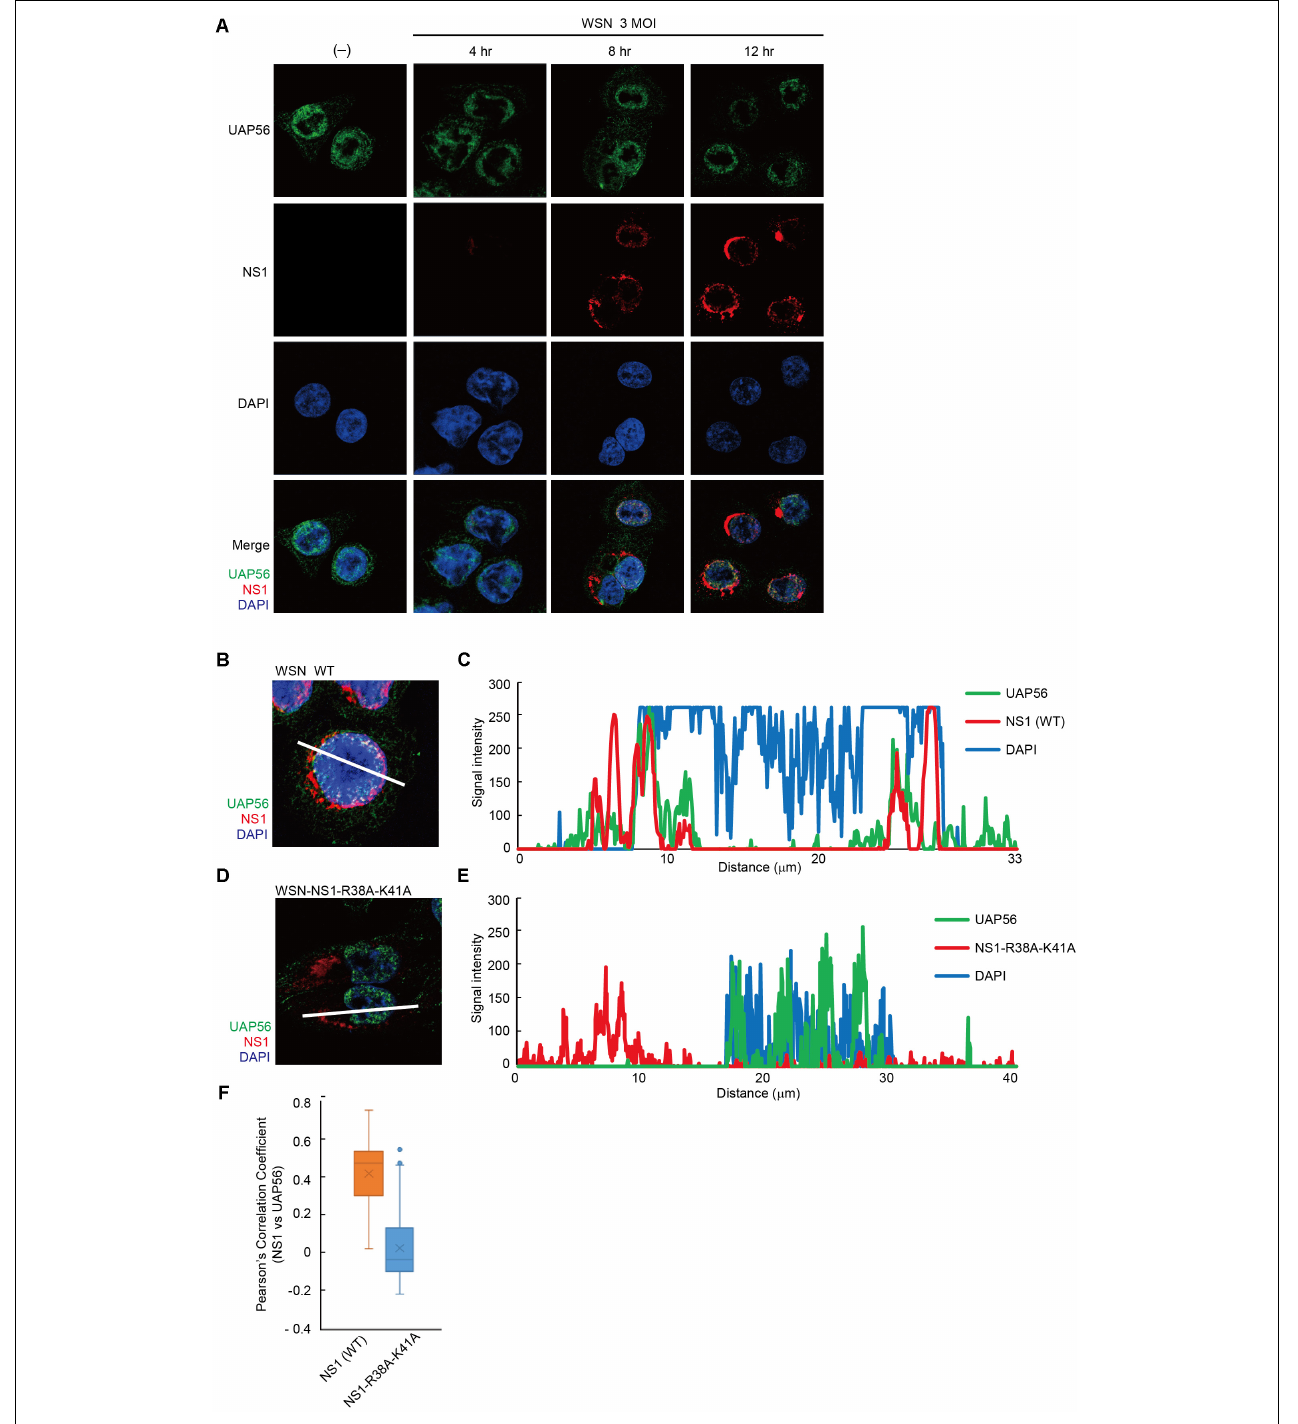
FIGURE 4 | Localization of UAP56 and NS1 in WSN-infected A549 cells. (A) A549 cells were infected with WSN virus at an MOI of three. At 4, 8, or 12 h post-infection, the cells were fixed with 4% paraformaldehyde in PBS. The cells were then analyzed with specific antibodies against UAP56 and NS1. (B–E) Representative immunofluorescence images of A549 cells at 12 h post-infection with wild-type (WT) WSN virus (B) or WSN-NS1-R38A-K41A mutant virus (D) at an MOI of 3. The cells were analyzed with anti-UAP56 (green) antibody, anti-NS1 (red) antibody, and DAPI (blue). (C,E) Signal intensities across the line shown in B , D , respectively, were plotted and analyzed by using LSM510 META and ZEN2009 software. (F) A549 cells infected with WSN WT virus ( n = 102 cells) or WSN-NS1-R38A-K41A mutant virus ( n = 100 cells) at an MOI of three for 12 h were imaged, and Pearson’s correlation coefficients for UAP56 and NS1 co-localization were determined for individual